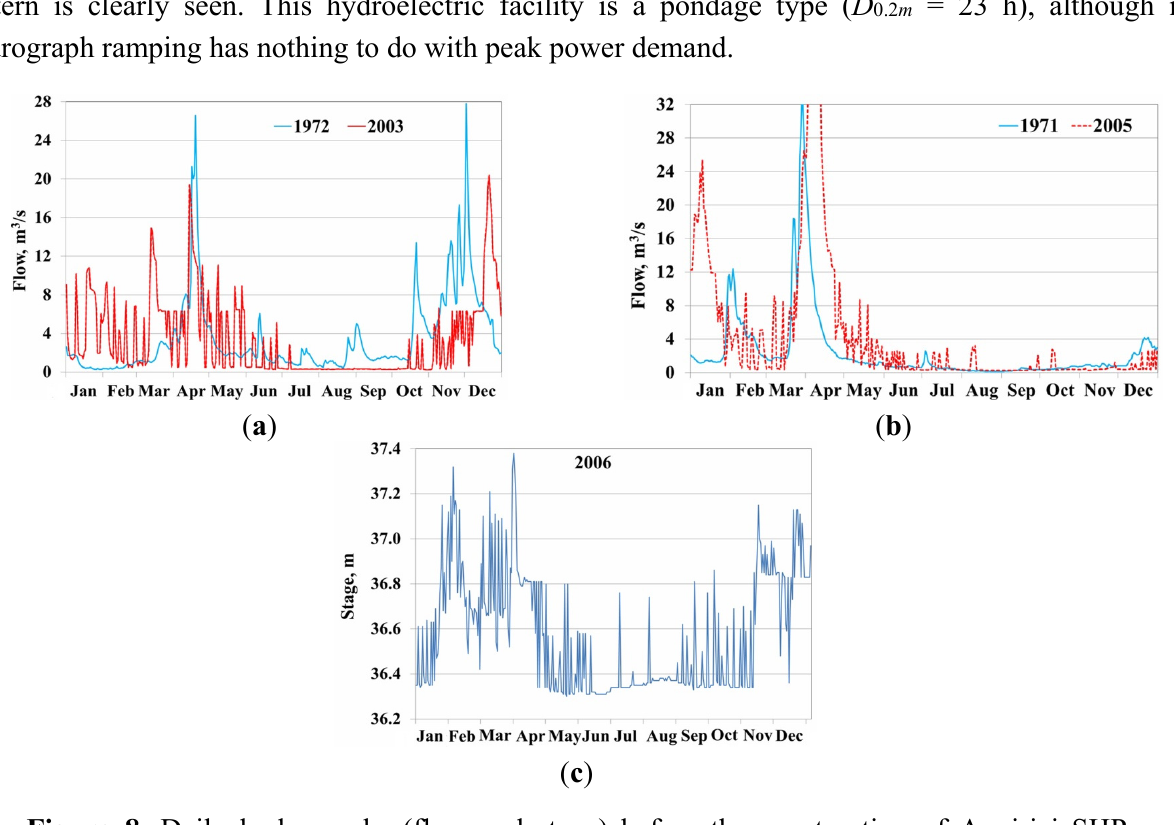
Figure 8. Daily hydrographs (flow and stage) before the construction of Angiriai SHP (1971 ( b ), 1972 ( a )) and under its operation (2003 ( a ), 2005 ( b ), 2006 ( c )). Gauging station Susve at